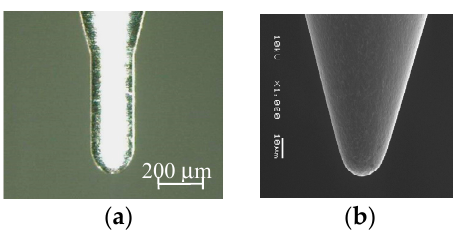
Figure 2. Blank holder and tensioner.